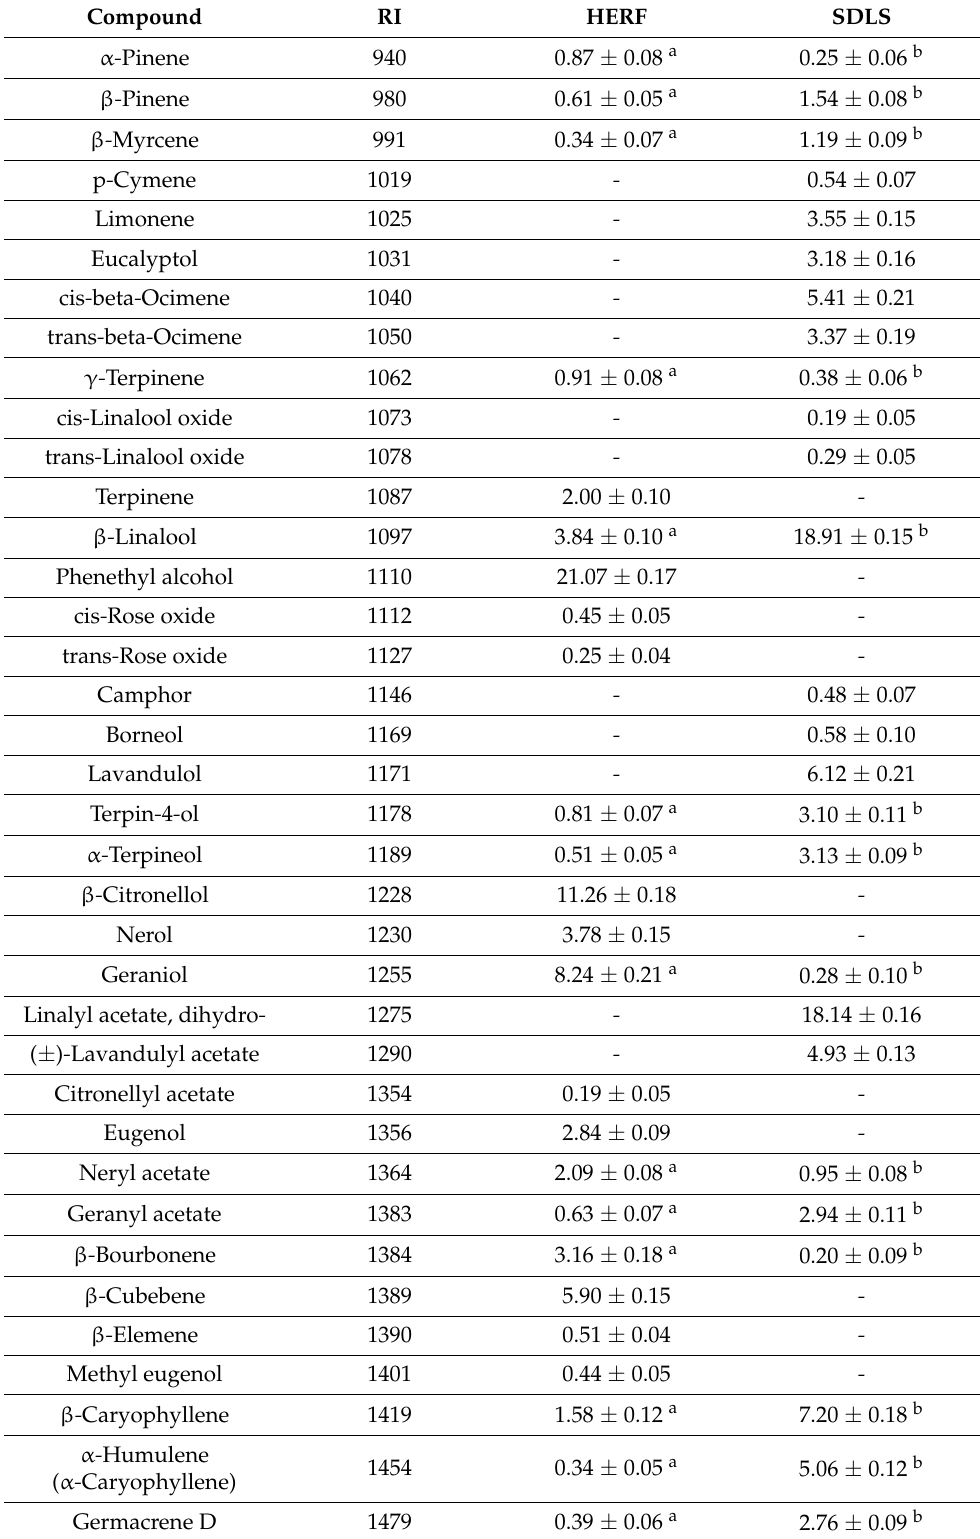
Table 3. Polar volatile metabolites in 70% ethanol extracts of hexane extracted rose flowers (HERF) and steam distilled lavender straw (SDLS), % of TIC (total ion